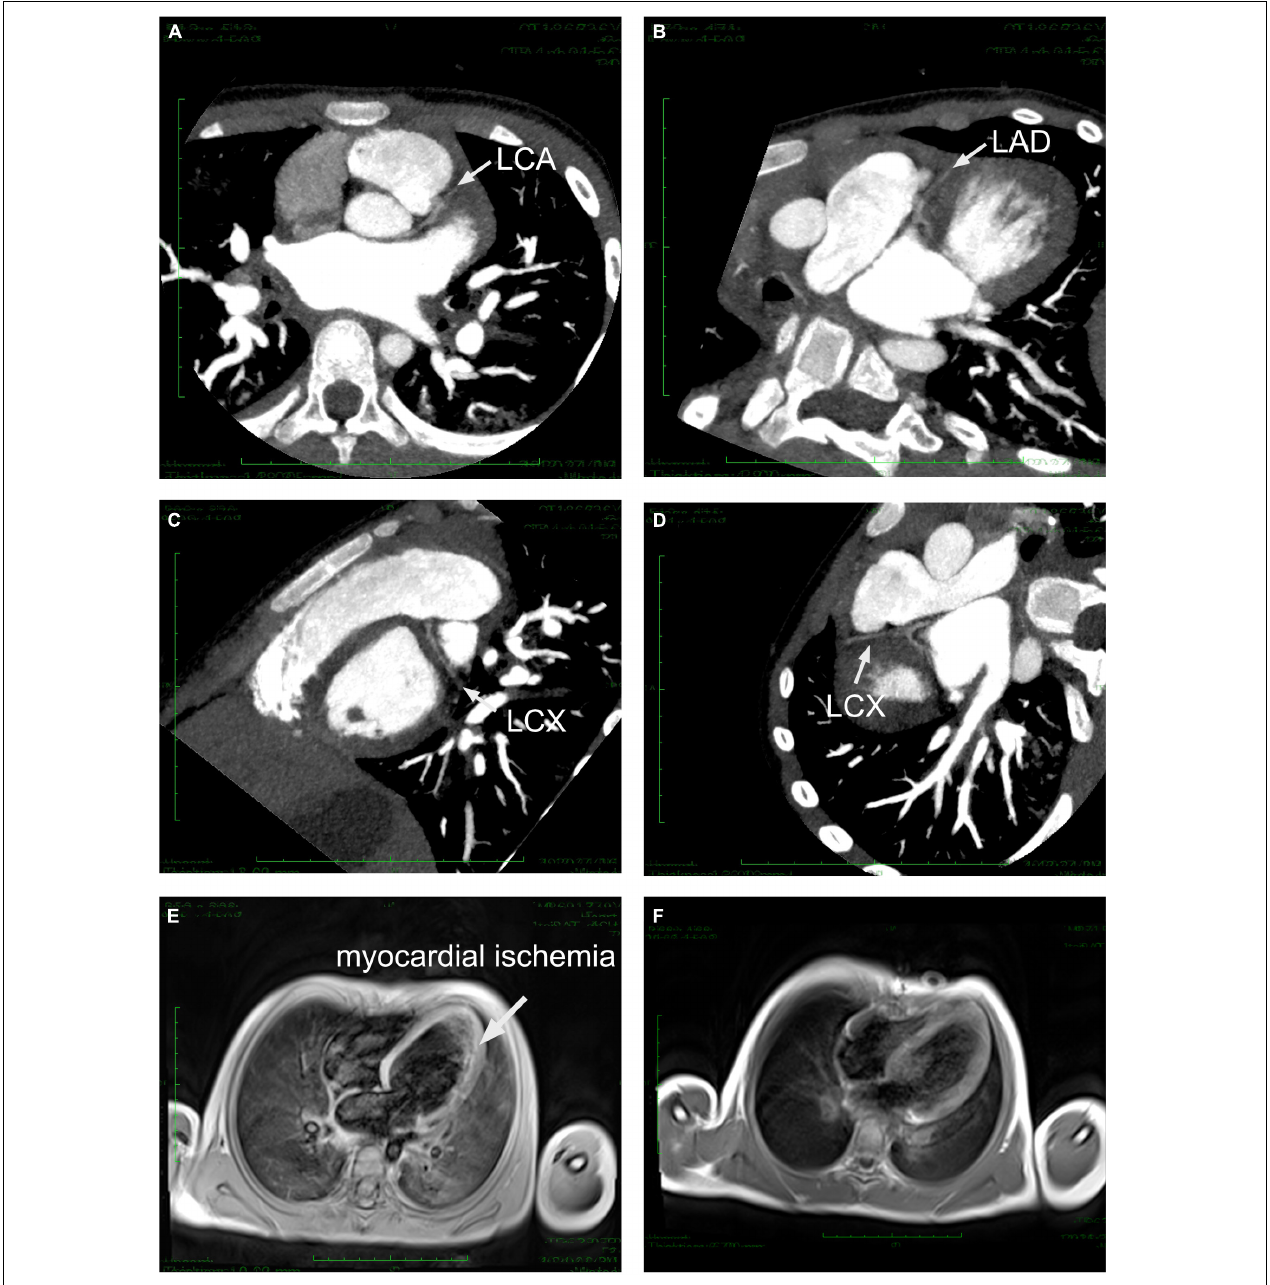
FIGURE 3 | Cardiac CTA and MRI imaging. (A) Left coronary artery originated from an abnormal location at the superior and posterior sites in the left coronary sinus. (B–D) LAD and LCX demonstrated severe dysplasia under several sections of CTA. (E) Cardiac MRI demonstrated significant myocardial ischemia and fibrosis in the left ventricular wall before surgical correction. (F) Cardiac MRI image after surgical correction revealed a normal perfusion. LCA, left coronary artery; LAD, left anterior descending; LCX, left